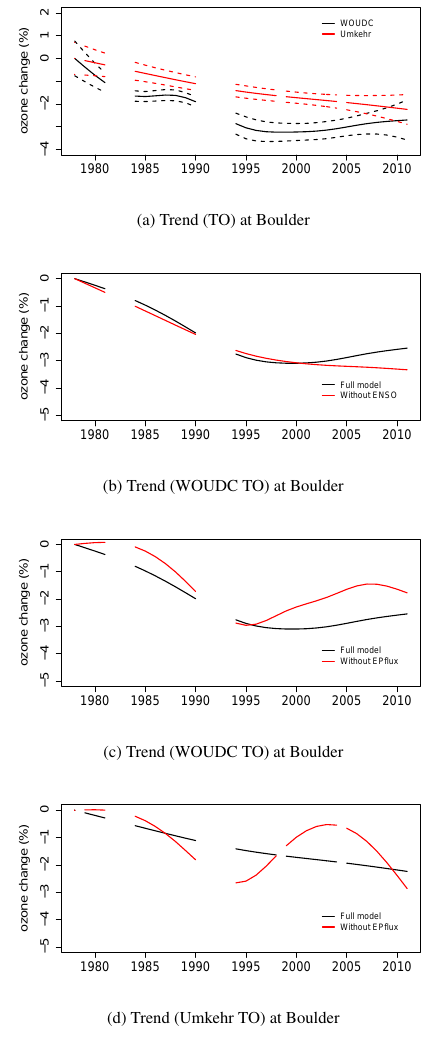
Fig. 17. Estimated trends for total column ozone at Boulder. (a): Ozone trends for Umkehr (in red solid line) and WOUDC (in black ozone trends for Umkehr (in red solid line) and WOUDC (in black solid line) TO, with their 95% confidence intervals in dotted lines solid line) TO with their 95% confidence intervals in dotted lines with the matching colour. (b): ozone trends for WOUDC TO ob- with the matching color. (b) Ozone trends for WOUDC TO obtained tainedfromthefullregressionmodel(onblack)andthemodelwith- from the full regression model (on black) and the model without out ENSO (in red). (c): ozone trends for WOUDC TO obtained ENSO (in red). (c) Ozone trends for WOUDC TO obtained from from the full regression model (in black) and the model without EP flux (in red). (d): ozone trends for Umkehr TO obtained from the the full regression model (in black) and the model without EP flux full regression model (in black) and the model without EP flux (in (in red). (d) Ozone trends for Umkehr TO obtained from the full red). regression model (in black) and the model without EP flux (in